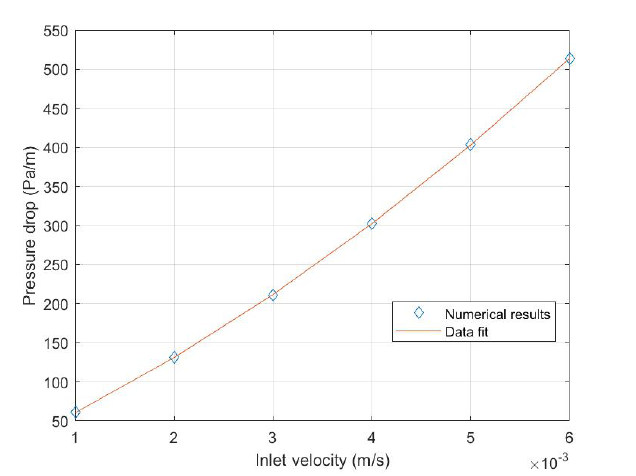
Figure 8. Pressure distribution for the case Re = 3.6 on three planes y / H = 1/3 ( a ) y / H = 1/2 ( b ) and y / H = 2/3 ( c ).